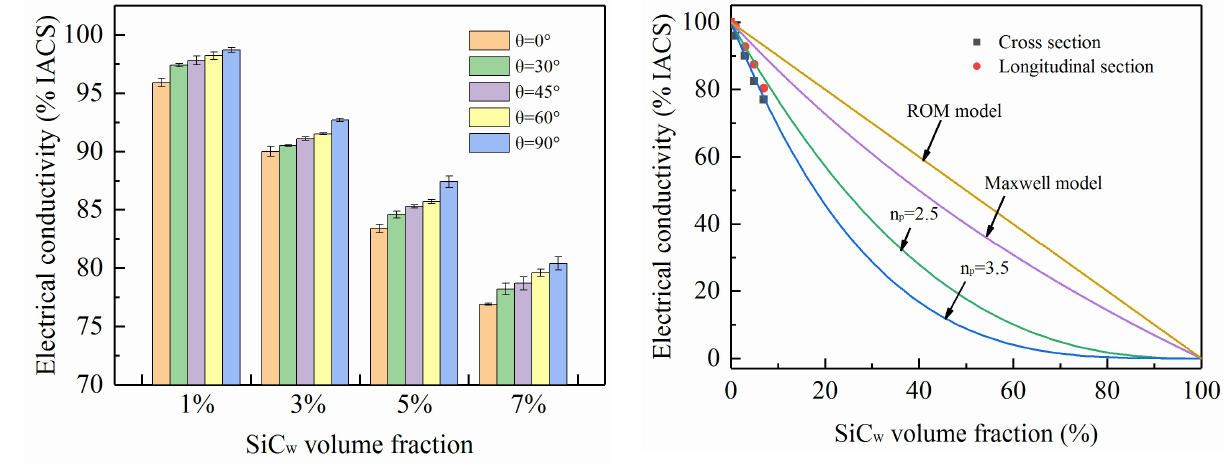
Figure 8: The calculated electrical conductivity of SiC w /Cu